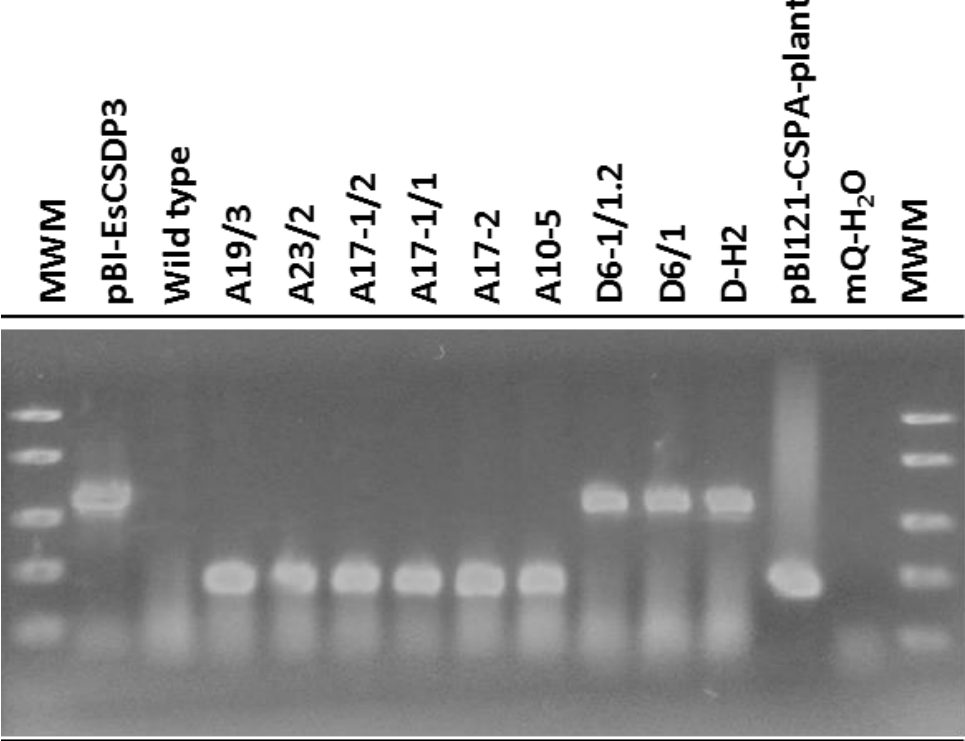
Figure 5. Multiplex-PCR analysis of cspA-plant and Escsdp3 in independent Km-resistant T 1 -generation of transgenic rape lines and wild type (MWM-molecular weight marker FastRulerTM Low Range DNA ladder-1500, 850, 400, 200, 50 bp).